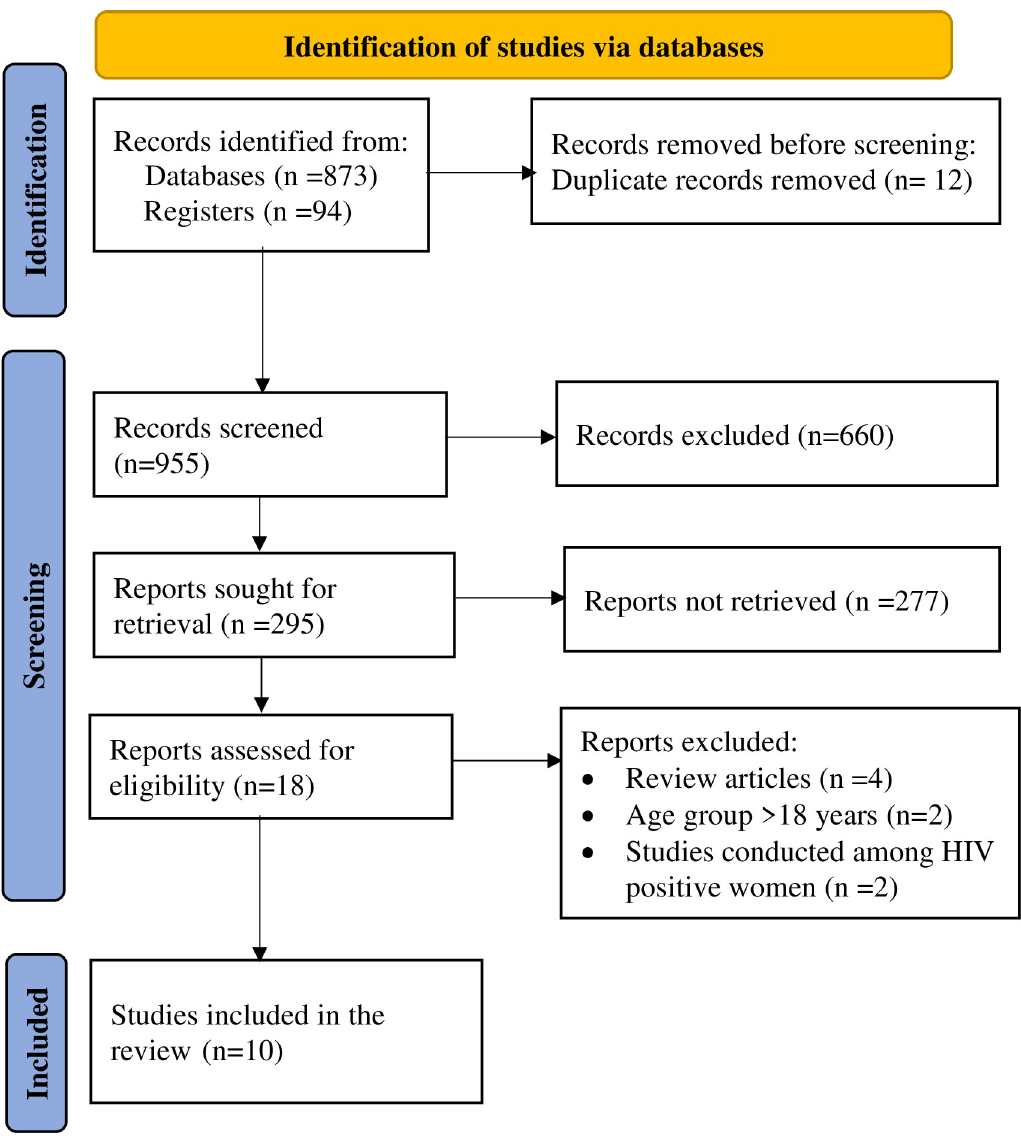
Fig 1. PRISMA flow-diagram that depicts the phases of study selection, March